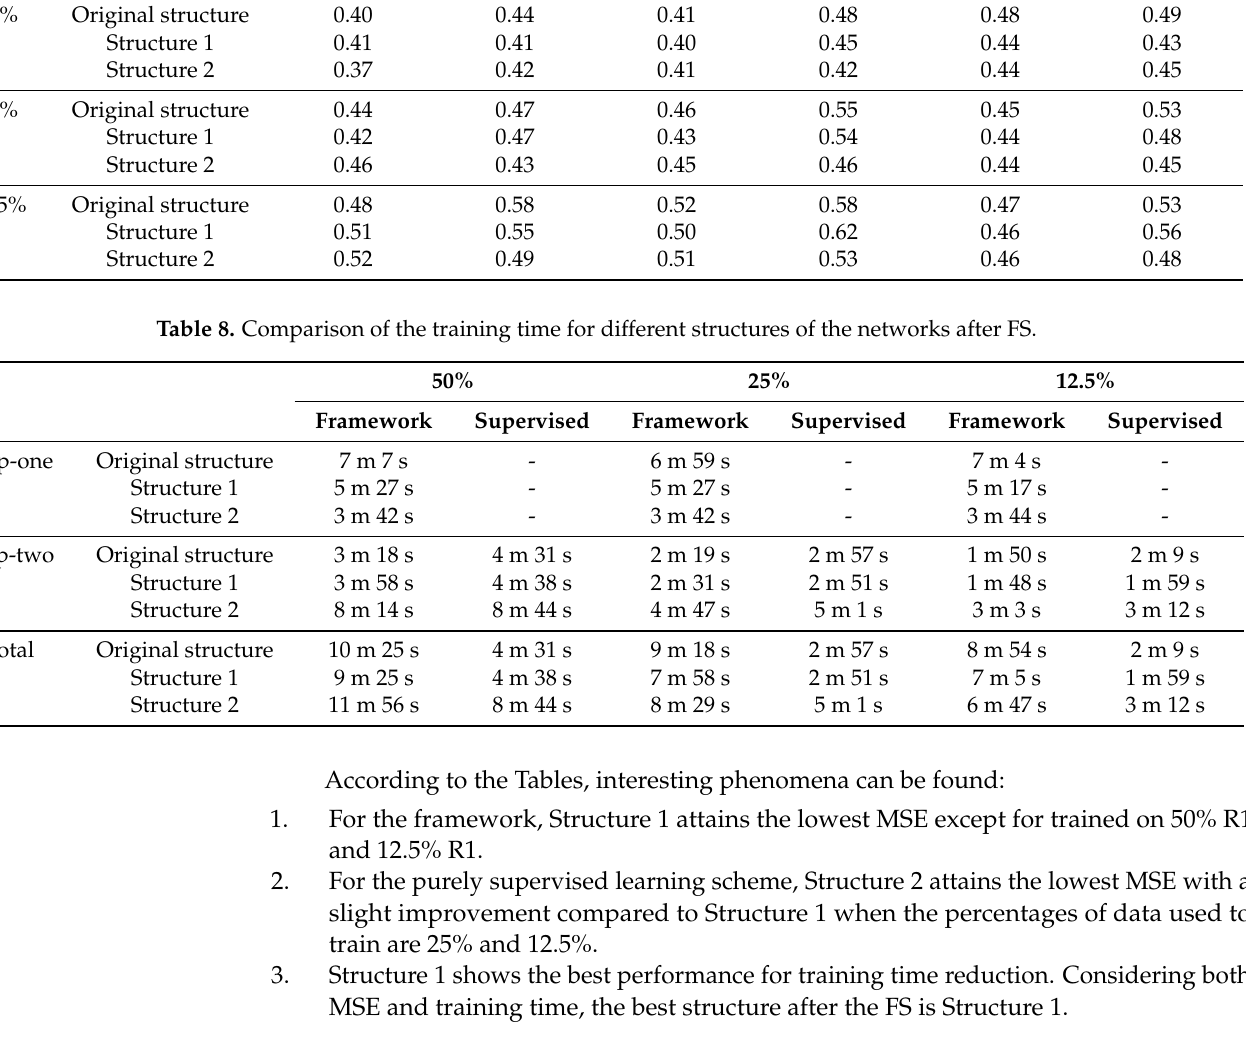
Table 7. Comparison of the mean MSE for different structures of the networks after FS. Trained on R1 Trained on R10 Trained on R21 Framework Supervised Framework Supervised Framework Supervised